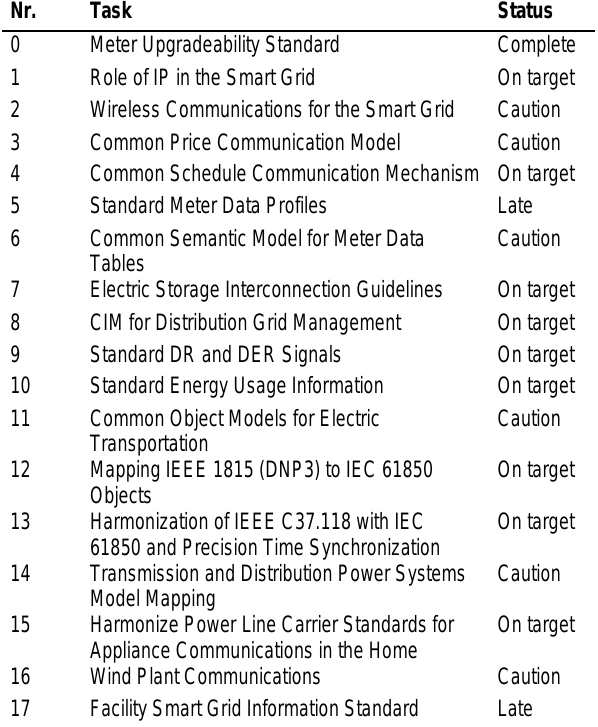
Table 2. Overview on PAP Tasks and last